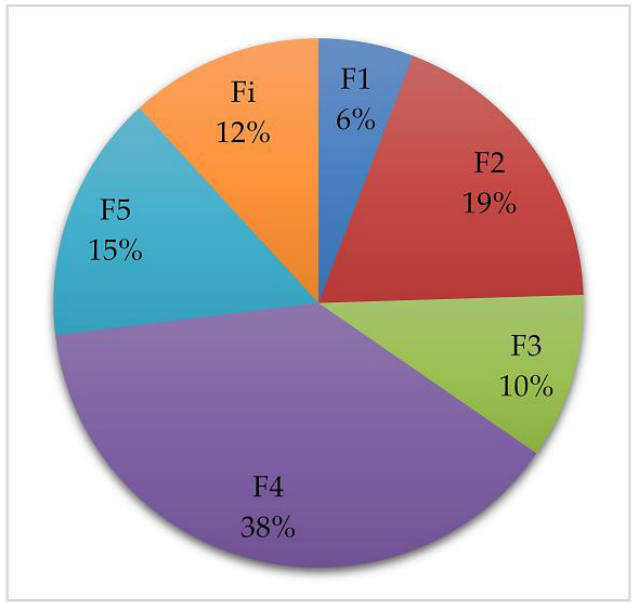
Figure 5. Average repartition of the grain durum wheat proteins in the 5 fractions and Fi fraction (means of all varieties and all locations). F1 = large glutenin aggregates; F2 = small glutenin aggregates; F3 = ω -gliadins and high molecular weight albumins such as β -amylase; F4 = α -, β -, and γ -gliadins; F5 = albumins-globulins, Fi = insoluble fraction.